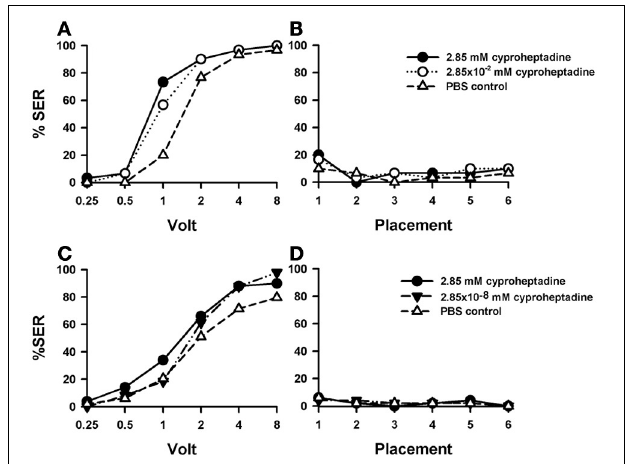
FIGURE 7 | Effects of 5-HT blocking on aversive responsiveness. (A,B) Two different groups of bees were injected with two different concentrations of the 5-HT antagonist cyproheptadine (2.85mM: n = 30; 2.85 × 10 − 2 mM: n = 30). A third group was injected with PBS as a control ( n = 30). Sting responsiveness was measured in response to a series of increasing voltages during shock trials (A) and during placement trials (B) . Both cyproheptadine concentrations induced a significant increase of shock responsiveness when compared to PBS controls [ F ( 2 , 87 ) = 7 . 81, p < 0 . 001] but not change of responsiveness during the placement trials. (C,D) A further replicate using a lower concentration of cyproheptadine. Two different groups of bees were injected with two different concentrations of cyproheptadine, the highest one used in the previous replicate (2.85mM: n = 50) and a lower one (2.85 × 10 − 8 mM: n = 49). A third group was injected with PBS as a control ( n = 49). Sting responsiveness was measured in response to increasing voltages during shock trials (C) and during placement trials in which the bees were placed in the setup without stimulation (D) . The highest concentration did induce a significant increase of responsiveness during shock trials [ F ( 1 , 97 ) = 4 . 79, p = 0 . 031]. The lowest concentration did not [ F ( 1 , 75 ) = 2 . 65, p = 0 . 11]. No differences were detected in the placement